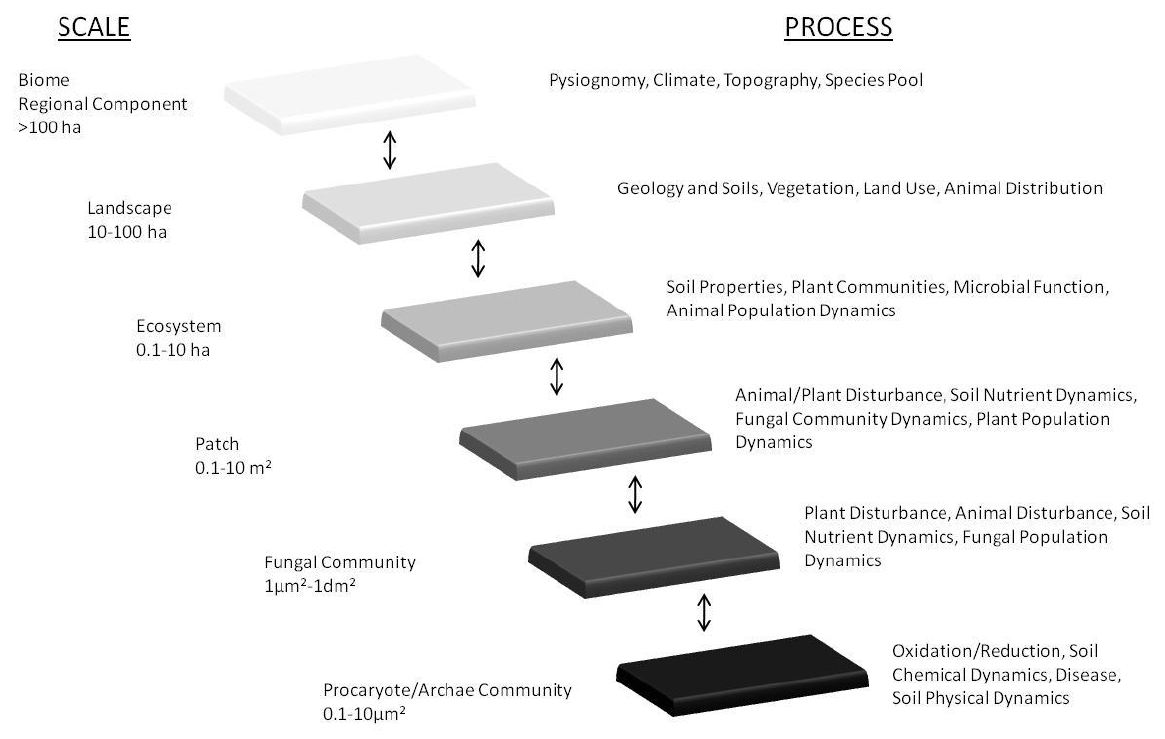
Figure 1. Concepts of hierarchy and scale in ecosystems. The relationship between scales (double-headed arrows ↔) is crucial for evaluating the impact of function of a lower scale on processes at higher scales. Processes may overlap from one scale to another and scales are also only approximate (Adapted from Friese et al.